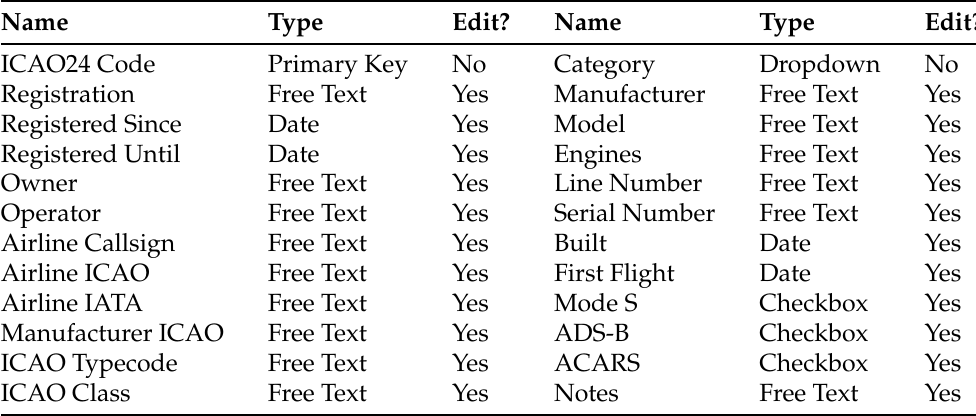
Table 1. Fields of the OpenSky aircraft